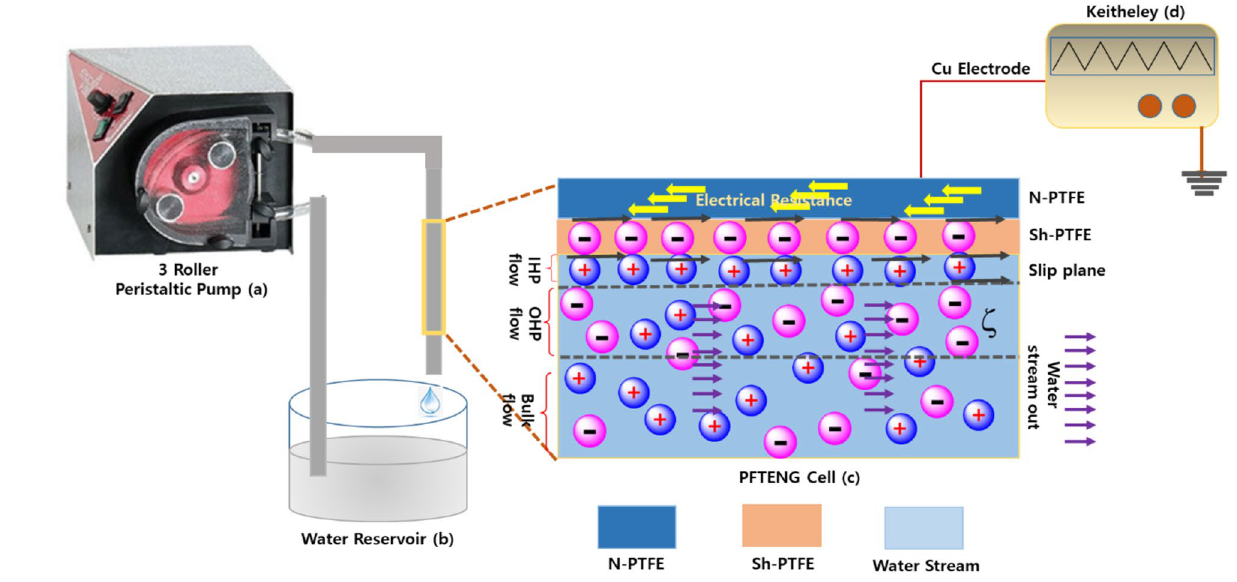
Figure 6. Mechanistic approach to generate the Electric double layer (EDL) for power supply through ( a ) peristaltic pump, ( b ) water reservoir ( c ) TENG cell showing the EDL = IHP + OHP at the interface of solid–liquid and the reduction of the zeta potential after the IHP to the bulk segment of the flow liquid. ( d ) Electrometer. (Supporting information showed the picture of live experimental set-up of for the proposed flow TENG